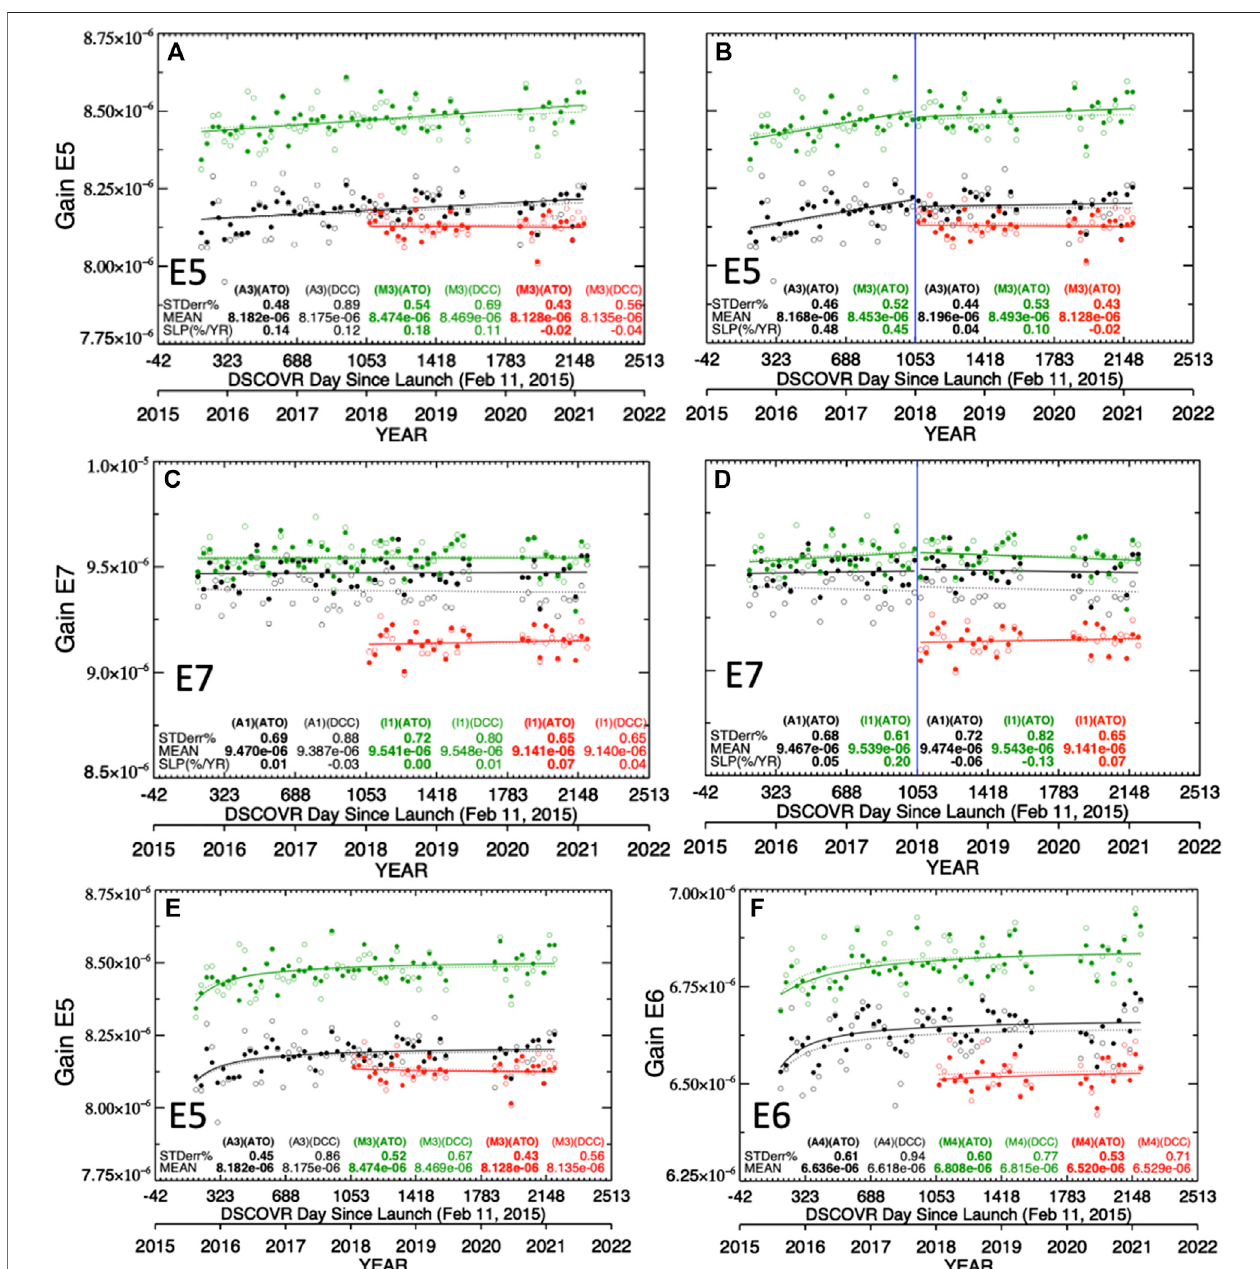
FIGURE 5 | (A) The time series of E-5 with M Aq -3 (black), V NPP -M3 (green) and V N20 -M3 (red) ATO-RM (solid circles and solid line) and DCC-RM (open circles and dotted line) monthly re fl ectance gains (ref/count) and lineartrends. Also shown are the standard error ( STDerr% ), mean gain (ref/count), and slope SLP ( %/YR ). (B) Same as (A) except for E-5 time series before 2018 and after 2018 as delineated by the vertical blue line. Both ATO-RM and DCC-RM monthly gains and linear trends are plotted but only the ATO-RM statistics are listed. (C) Same as (A) except for E-7, (D) same as (B) except for E-7. (E) same as (A) except an asymptotic trend is used. (F) same as (E) except for